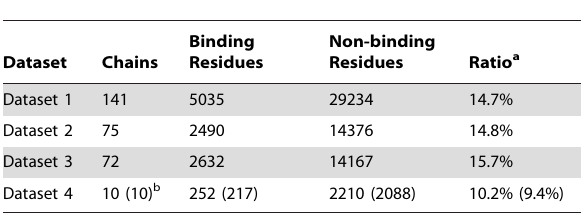
a Ratio=number of binding residues/(number of binding residues + number of non-binding residues). b The information of apo heme proteins used in Dataset 4.